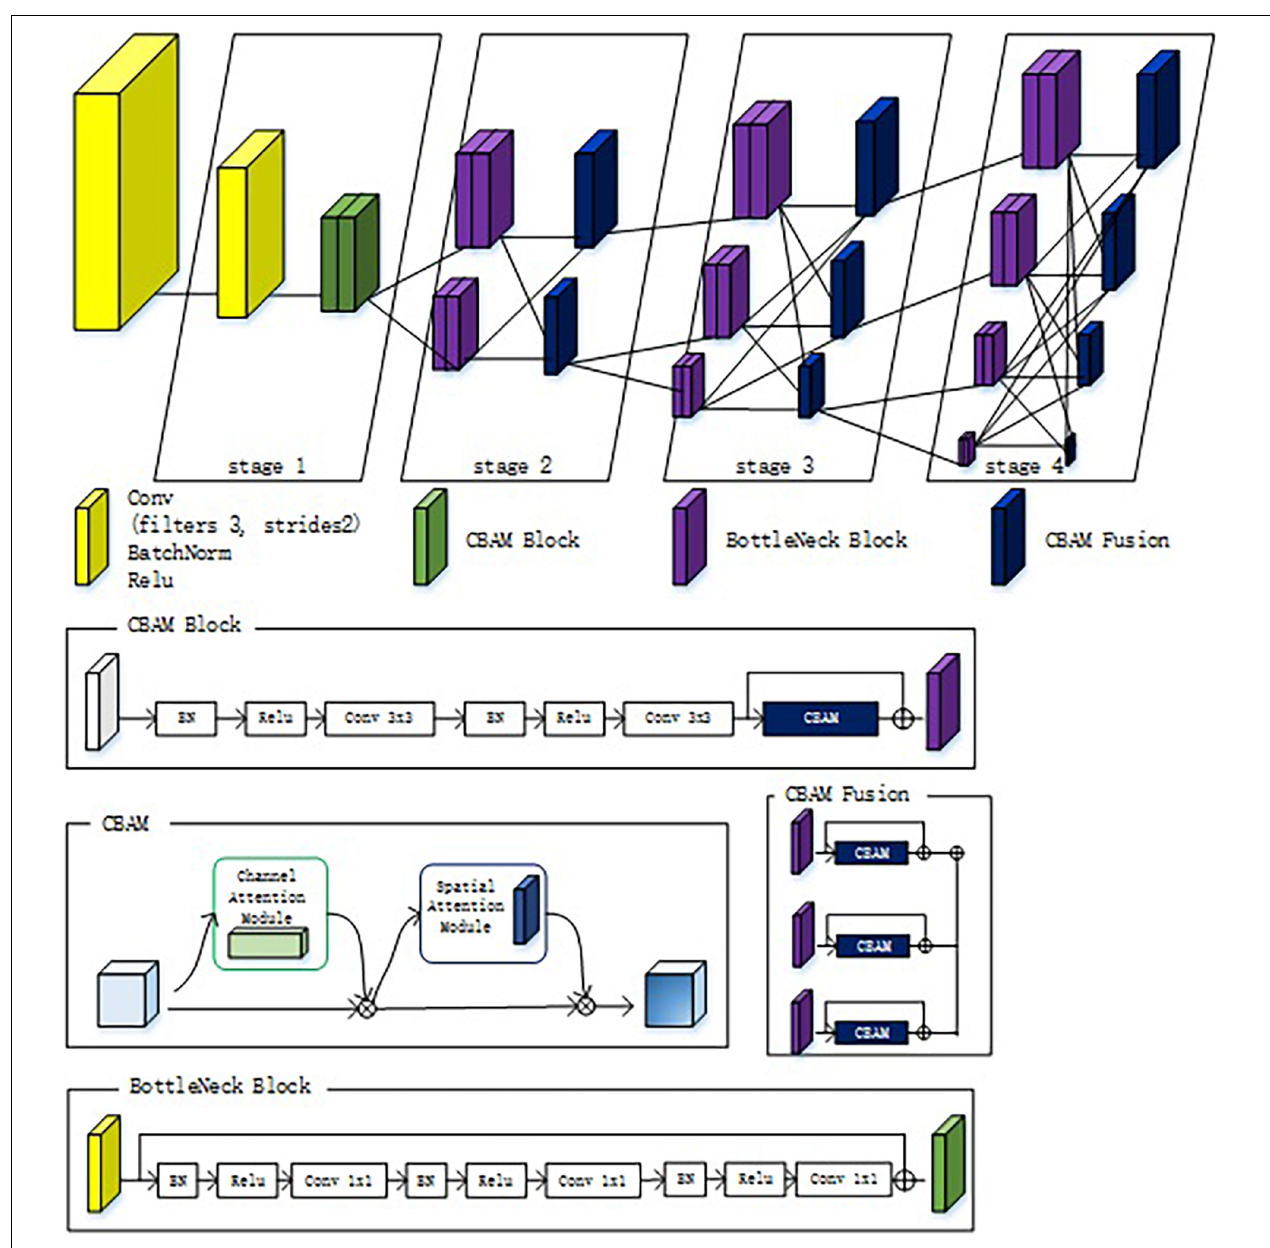
FIGURE 6 | High-resoultion network (HRNet) model with CBAM attention